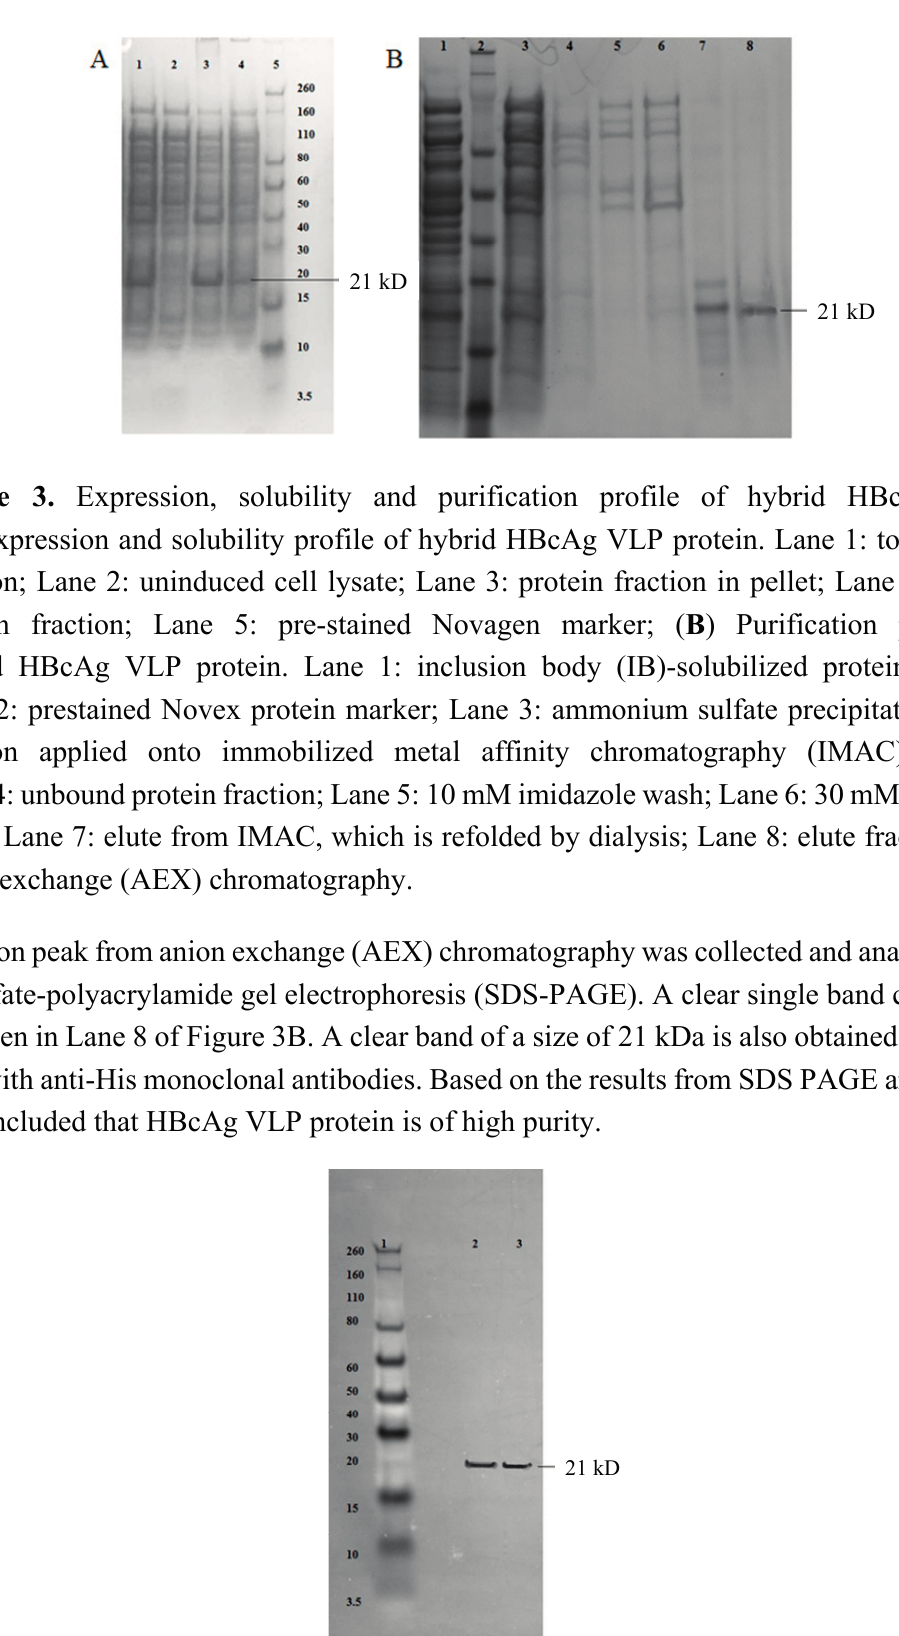
Figure 4. Western blot analysis of hybrid HBcAg VLP protein. Lane 1: prestained Novex protein marker; Lane 2: refolded hybrid HBcAg VLP protein; Lane 3: elute fraction from AEX